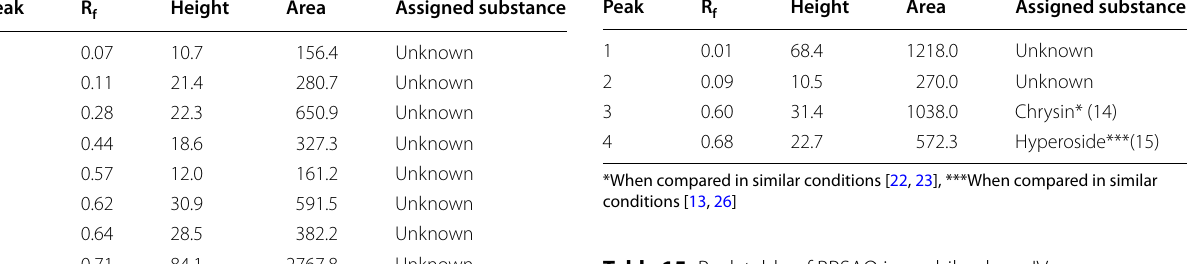
Table 15 Peak table of BPSAQ in mobile phase